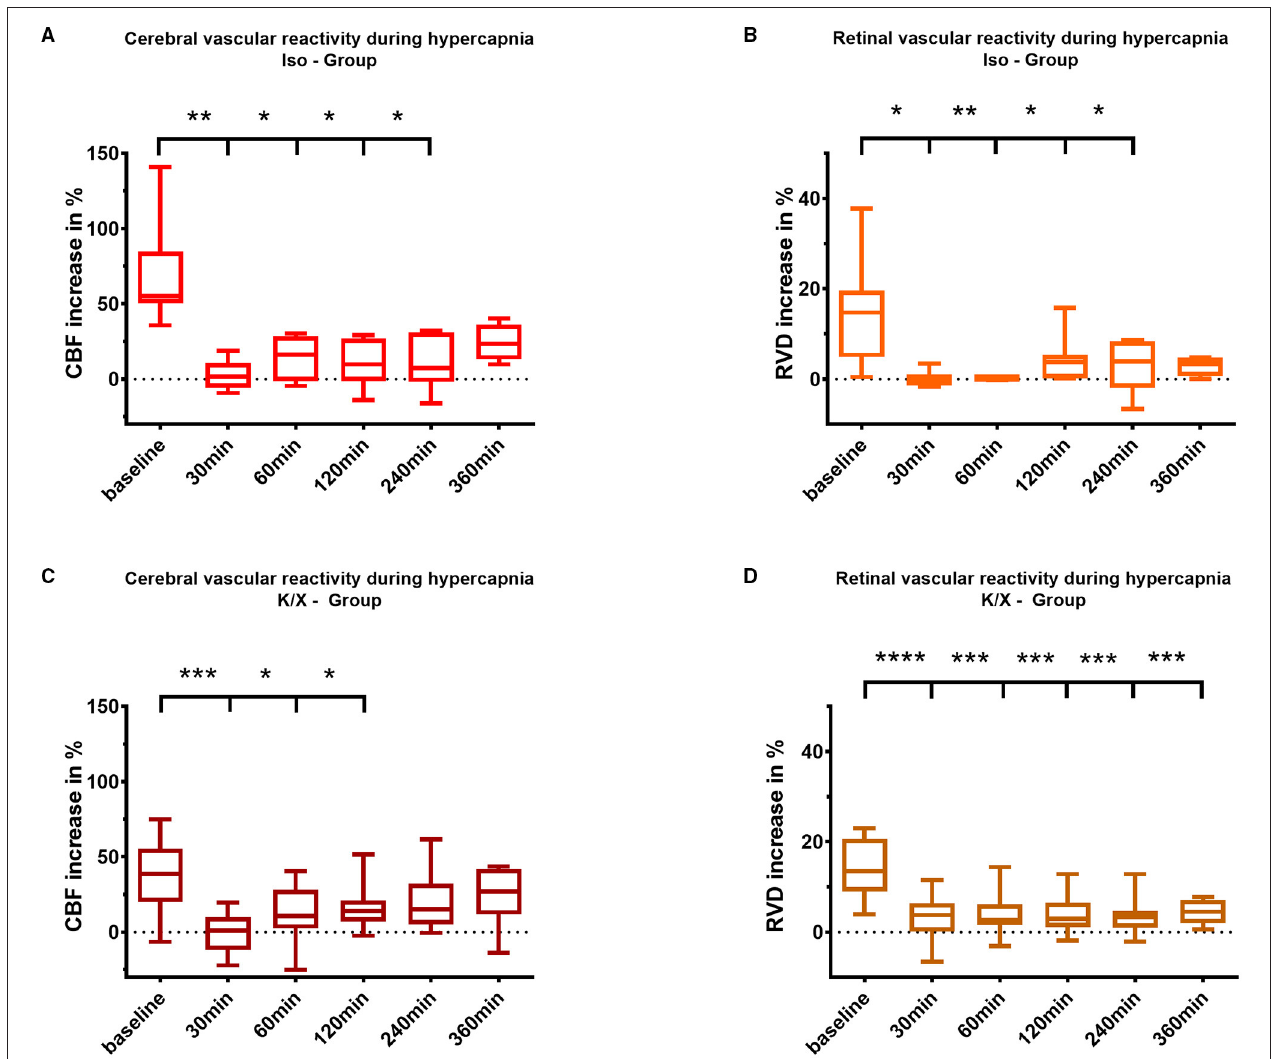
FIGURE 4 | Cerebral and retinal vascular reactivity to hypercapnia after SAH. Iso—Group: Cerebral vascular reactivity (A) as well as retinal vascular reactivity (B) to hypercapnia were impaired up to 240min after SAH; K/X—Group: Cerebral CO 2 reactivity was disturbed up to 120min after SAH (C) , whereas impairment of retinal vessels persisted throughout the whole measurement period of 360min (D) . SAH, subarachnoid hemorrhage; Iso, Isoflurane; K/X, Ketamine/Xylazine; CBF, cerebral blood flow; RVD, retinal vessel diameter; boxes show median and 25% and 75% percentile and whiskers show data range; * p < 0.05, ** p < 0.01, *** p < 0.001, **** p <